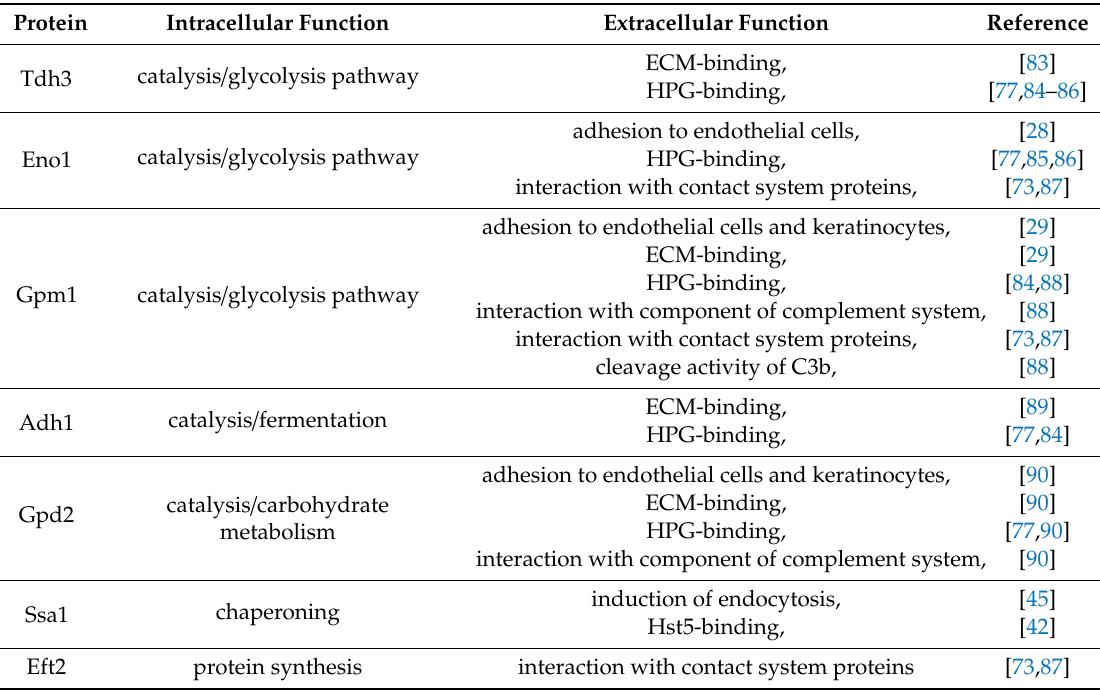
Table 1. Intracellular and extracellular functions of representative C. albicans moonlighting